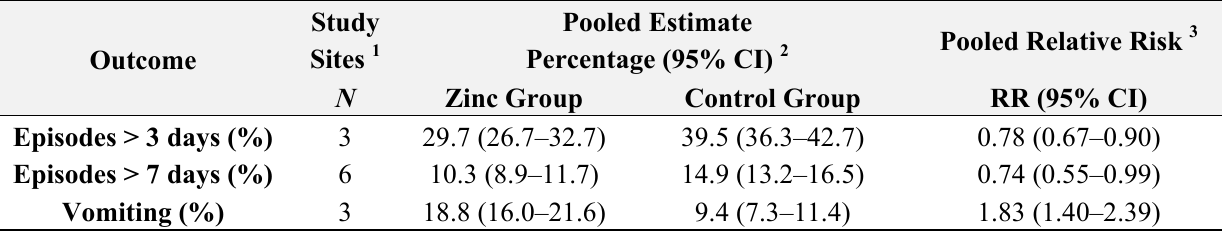
Table 3. Pooled relative risk of select outcomes for non-Chinese